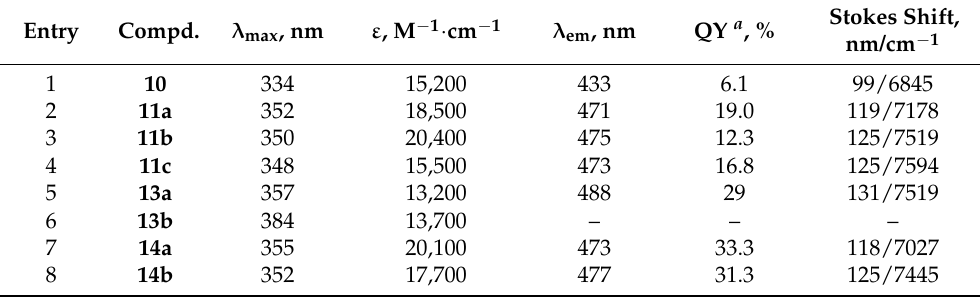
Table 1. Photophysical characteristics of DATs 10 , 11a – c , e , 13a , b , and 14a , b in CHCl 3 ( c = 5 × 10 − 5 M for adsorption and c = 5 × 10 − 6 M for emission).